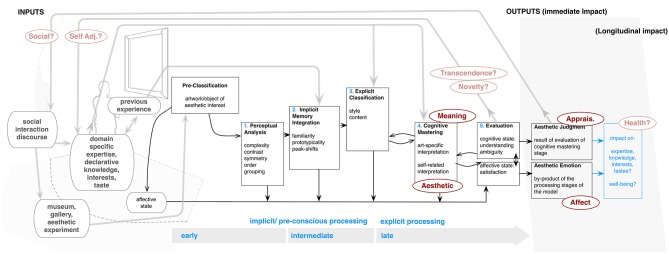
Leder model (adapted from Leder et al., 2004; Leder and Nadal, 2014).